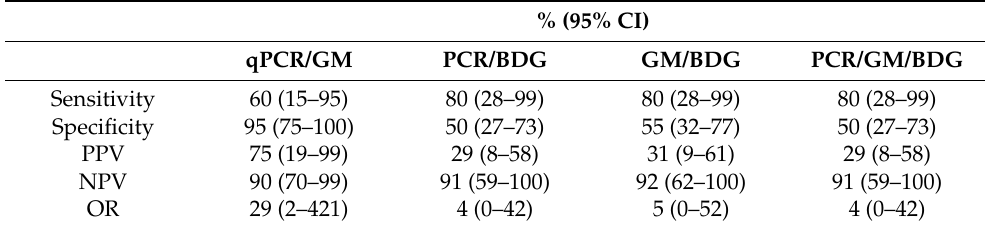
Table 3. Clinical performance of different assay combinations in probable IA and possible IFD cases. PPV and NPV, positive and negative predictive value, respectively; OR, odds ratio; CI, confidential